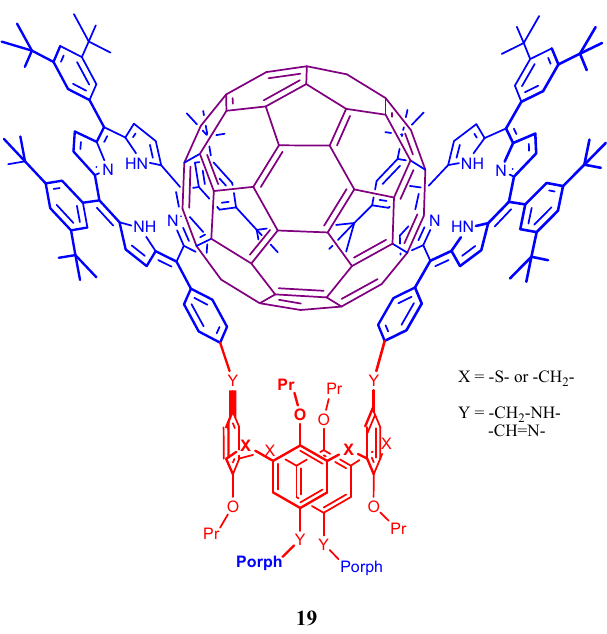
Figure 20. Molecular tweezer ( 19 ) based on aminoporphyrin and tetraformylcalixarene and its selectivity towards C . 70